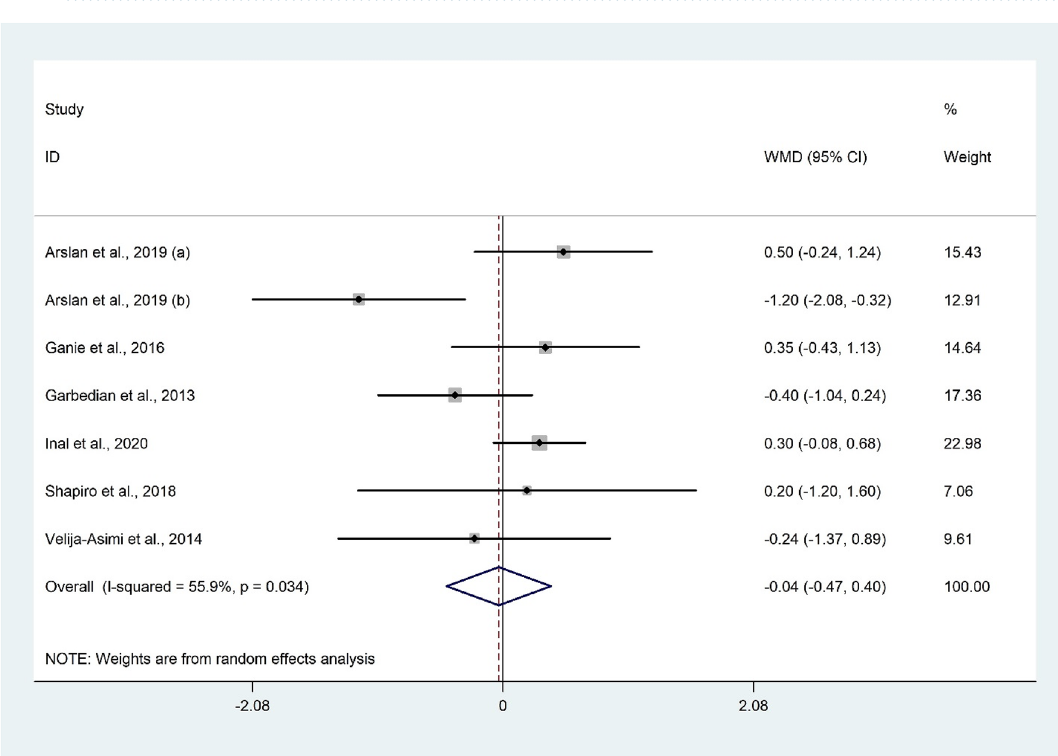
Figure 4. Forrest plot of the comparison of the FSH between women with vitamin D insufficiency/deficiency and sufficient